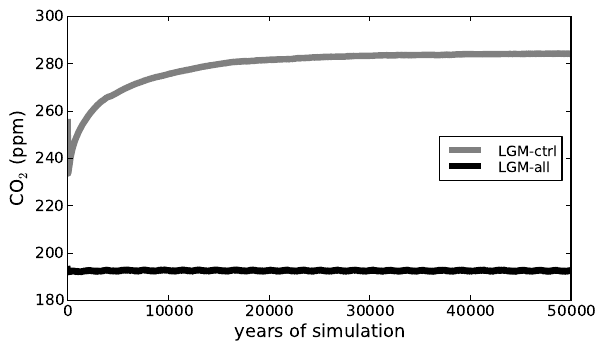
Fig. 13. Equilibrium simulations with LGM boundary conditions (LGM ice sheets and orbital parameters) with carbonate compen- sation (“LGM-ctrl”) and with the combination of the three addi- tional mechanisms (“LGM-all”, sinking of brines, interactive diffu- sion and iron fertilization).